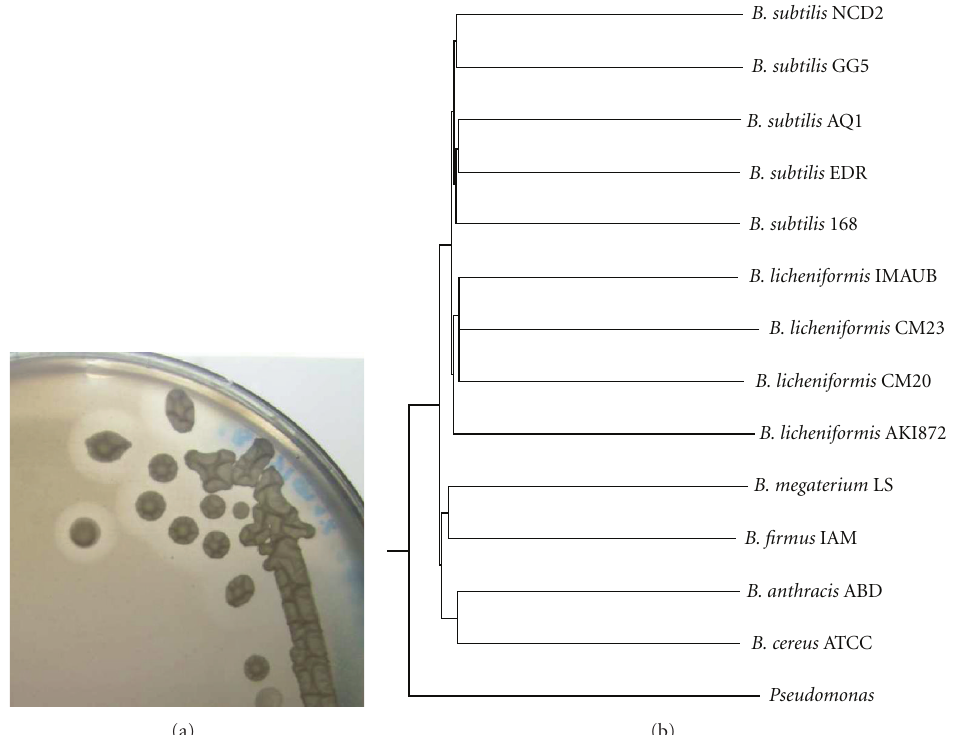
Figure 1: The morphology of newly isolated strain AQ1. Colony morphology on LB xylan agar medium (a) and its phylogenetic tree analyses